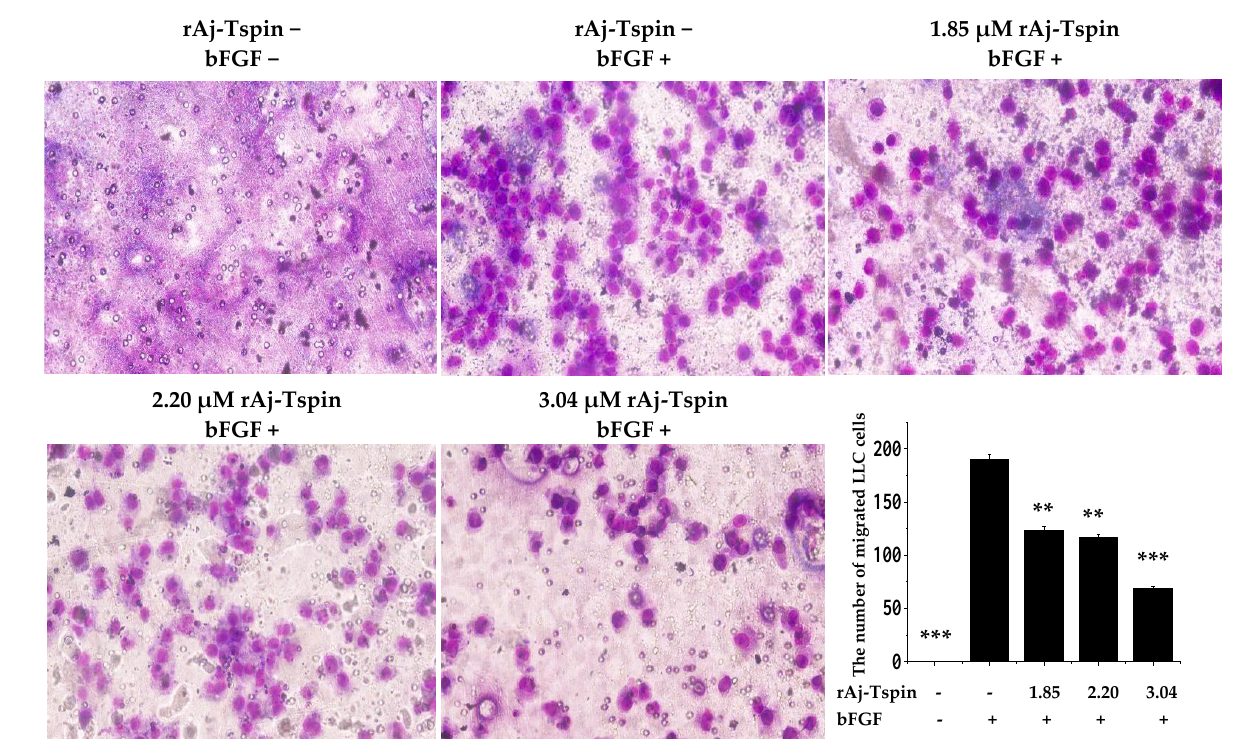
Figure 10. rAj-Tspin inhibited the migration of LLC cells (OLYMPUS optical microscopy, 200×). ** and ***, respectively, indicate p < 0.01 and p < 0.001 (compared with the empty-medium and bFGF treatment groups).